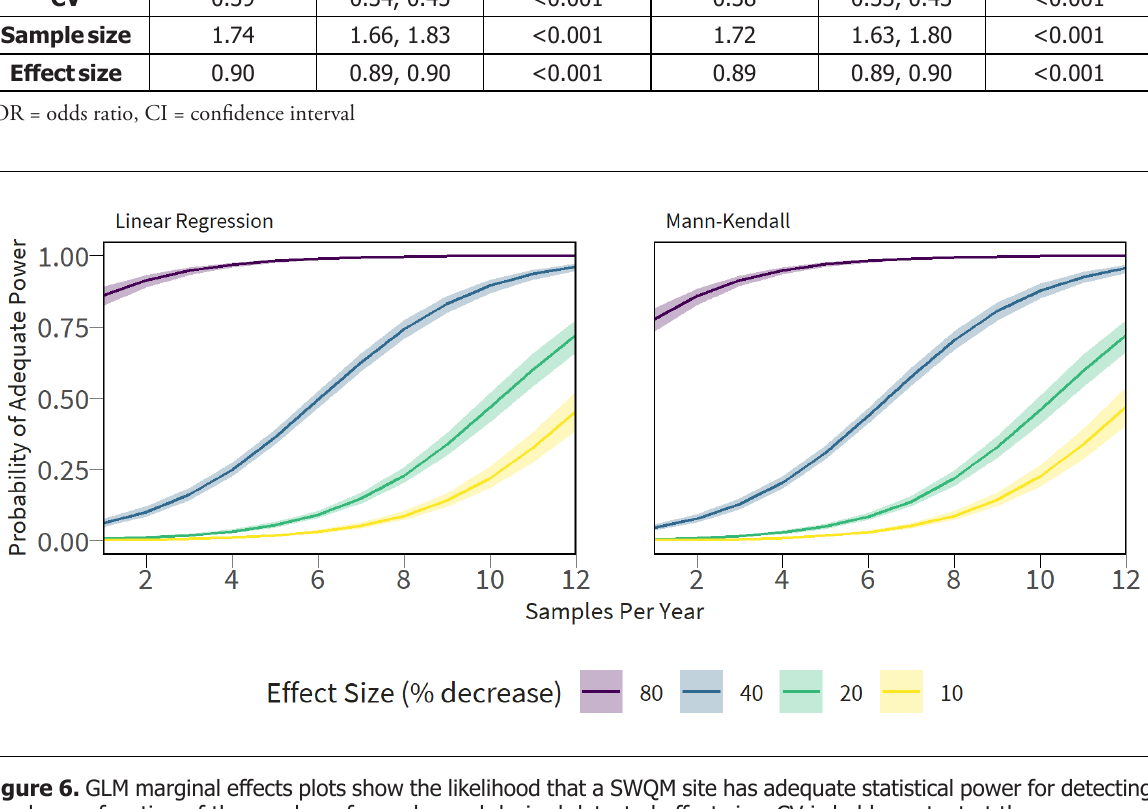
Figure 6. GLM marginal effects plots show the likelihood that a SWQM site has adequate statistical power for detecting trends as a function of the number of samples and desired detected effect size. CV is held constant at the mean.